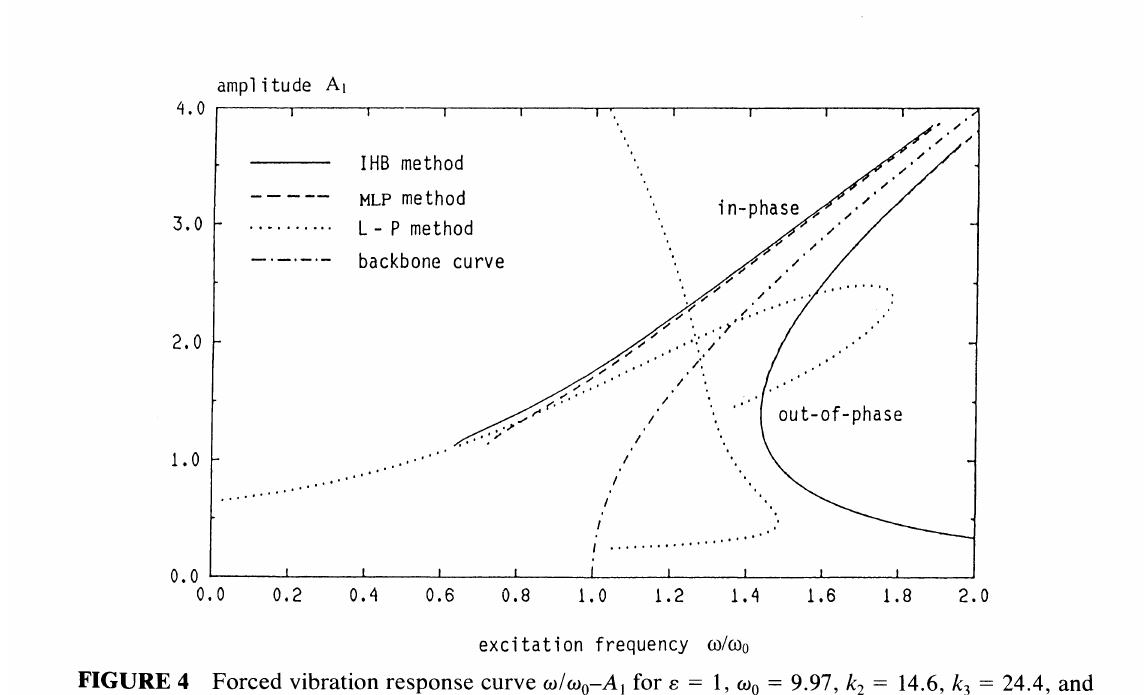
FIGURE 4 Forced vibration response curve wlwo-AJ for e = 1, Wo = 9.97, k2 = 14.6, k3 = 24.4, and p =